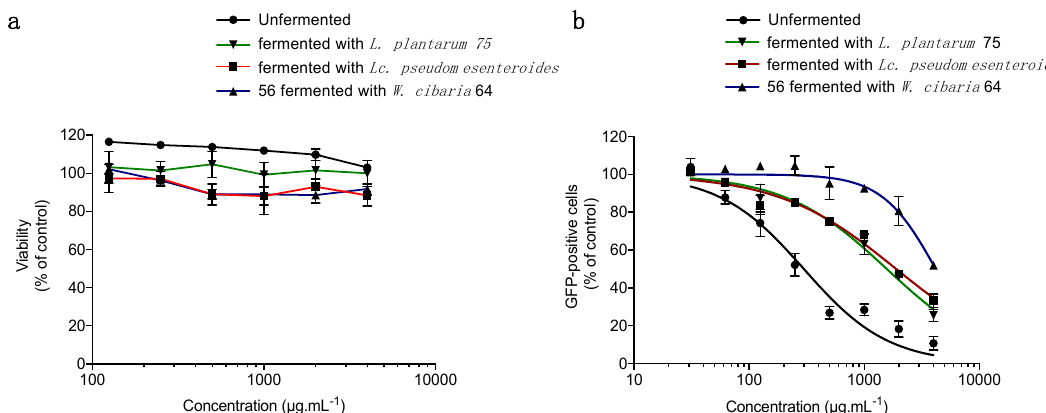
Figure 3. Lactic fermentation of papaya pulp affects its antiviral activity against ZIKV. ( a ) A549 cells were incubated for 48 h with two-fold serial dilutions (125–4000 µg/mL) of extracts of papaya pulp fermented by L. plantarum 75, Lc. pseudomesenteroïdes 56 or W. cibaria 64. Unfermented papaya pulp extract was used as a positive control. Cell viability was assessed through the MTT assay. Results are means ± SD of four independent experiments and are expressed as relative value compared to non-treated cells. ( b ) A549 cells were infected with an input of ZIKV GFP of 2 PFU/cell in the presence of different concentrations (31–4000 µg/mL) of fermented papaya pulp extracts. Unfermented papaya pulp extract was used as a positive control. Flow cytometric analysis of GFP fluorescence was performed 24 h post-infection. The results shown are means ± SD of three independent experiments and are expressed as relative value compared to untreated infected cells.